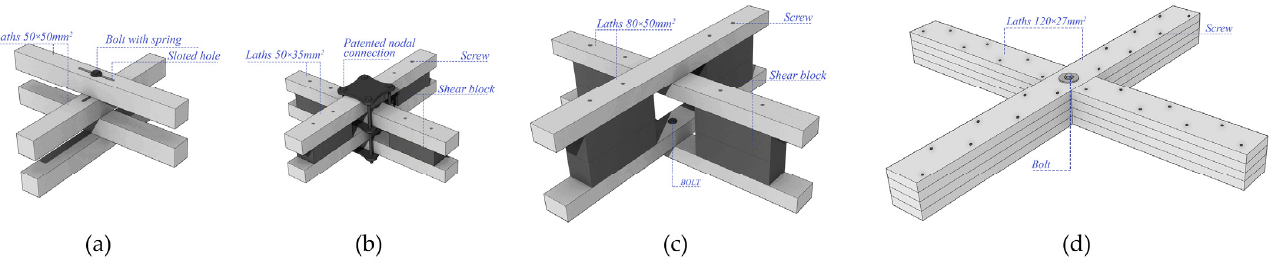
Figure 1. Multilayer system in traditional elastic timber gridshells: ( a ) the Mannheim Multihalle; ( b ) the Weald & Downland Living Museum; ( c ) the Savill Garden; ( d ) the Polydôme EPFL.